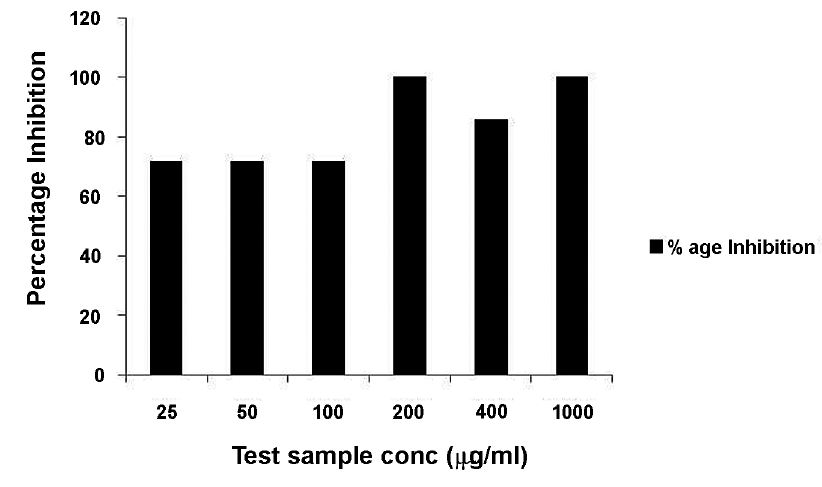
Figure 1 – Effect of Tribulus terrestris on nucleation of